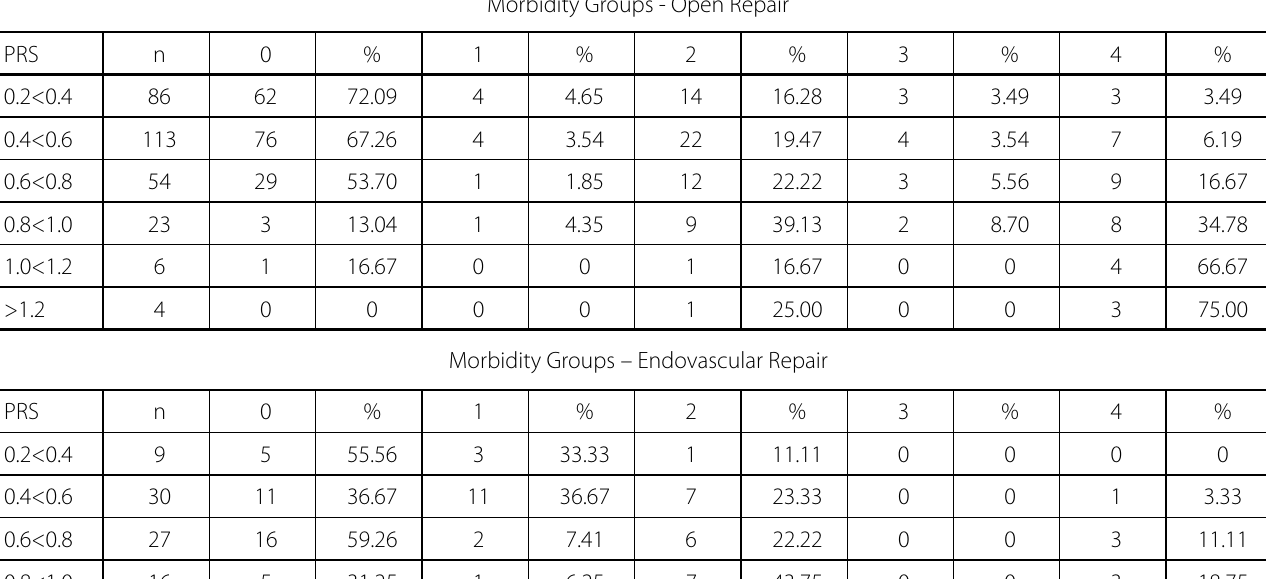
Table 3. Distribution of patients submitted to OR or EVAR into the morbidity classification, according to the PRS value. Morbidity Groups - Open Repair